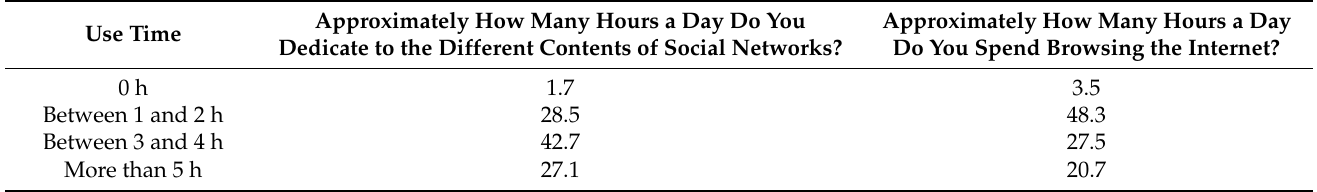
Table 1. Percentages of time intervals of use in social networks and the Internet.